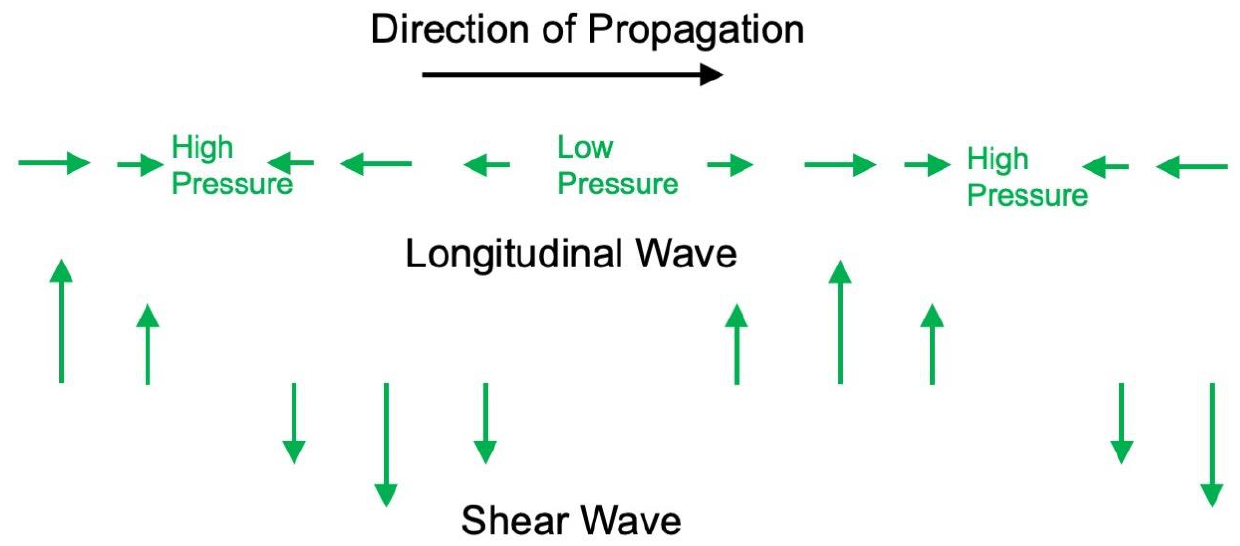
Figure 8. A longitudinal wave has a displacement (green arrows) parallel to the direction the wave propagates. A shear wave has a displacement perpendicular to the direction the wave propagates.